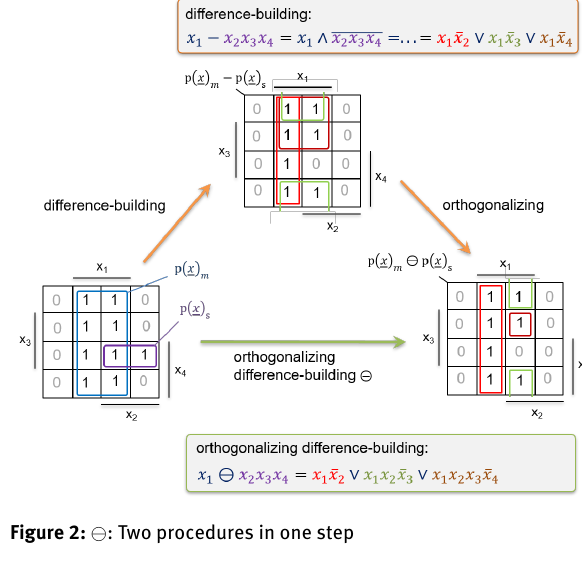
but homogenous in their covering of 1s. They only